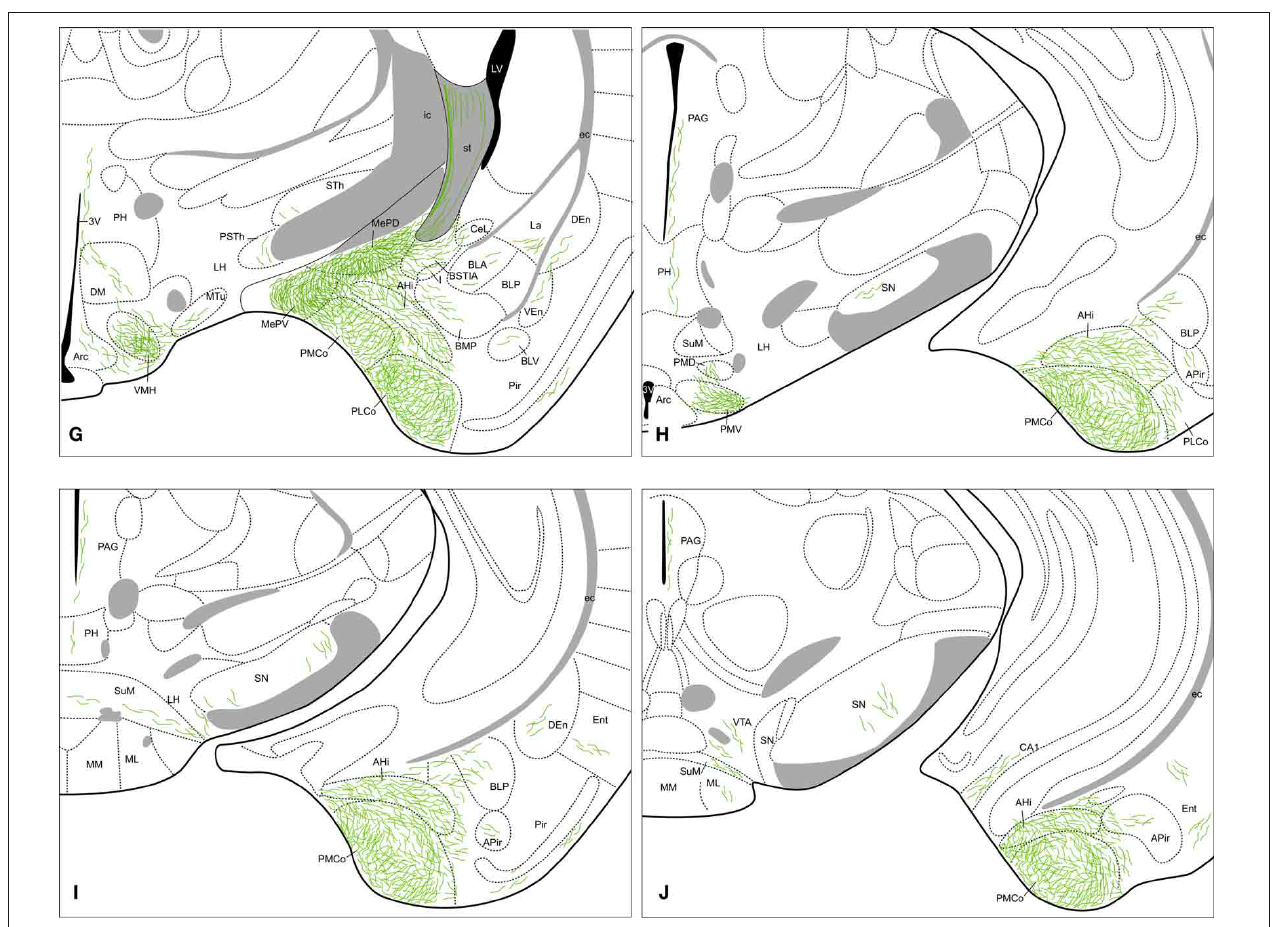
FIGURE 7 | Summary of the distribution of anterograde labeling following a tracer injection in the MePD, plotted onto semi-schematic drawings of transverse sections through the mouse brain. The injection